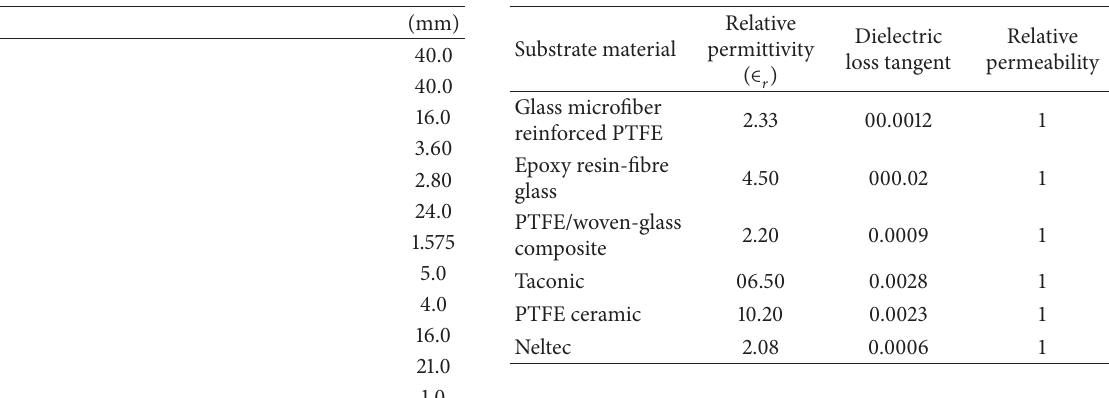
Table 1: Proposed antenna specification. Table 2: Dielectric properties of substrate